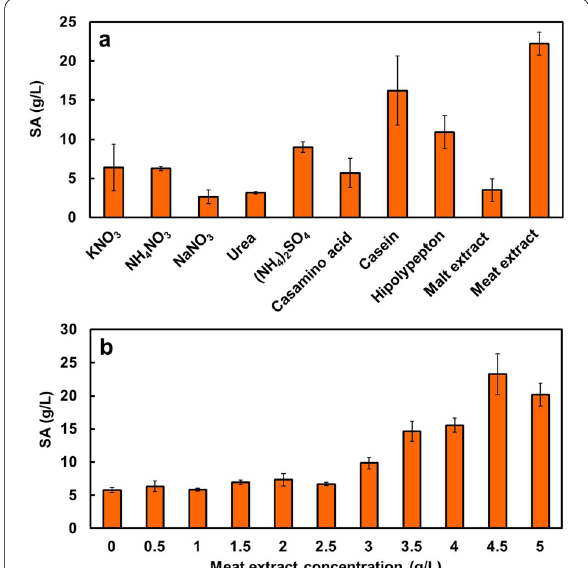
Fig. 7 Effect of nitrogen source on spiculisporic acid production by T . trachyspermus NBRC 32238. a Comparison of spiculisporic acid production with various nitrogen sources. b Spiculisporic acid production with meat extract at concentrations of 0–5 g/L.